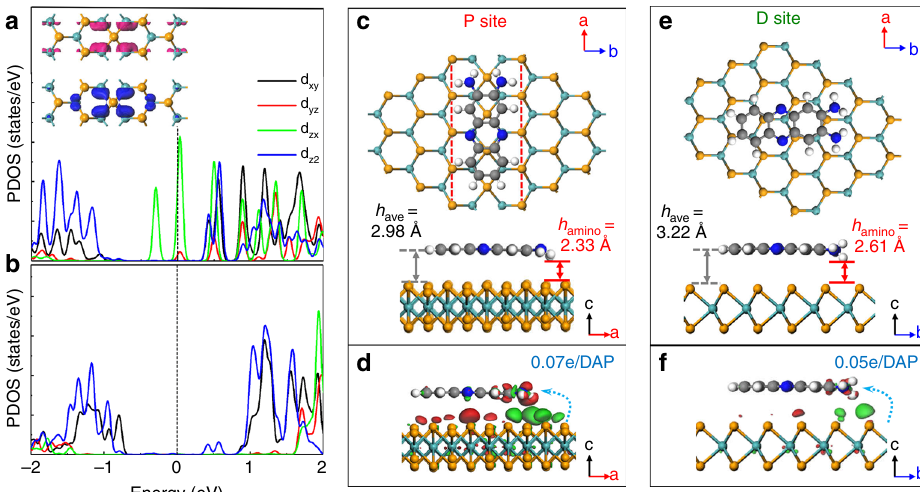
Fig. 5 Optimised con fi gurations of DAP molecules adsorbed on single-layer MoSe 2 surface. a , b The projected density of states of Mo atoms in the MTB and far away from the MTB (only spin-up states are shown here). The inset in a is the partial charge density of electronic states near Fermi level (pink and blue colours denote the states in the range of [0 – 0.3] eV and [ − 0.3-0] eV respectively) with an isosurface value of 2.0× 1.0 − 4 e/Å 3 . c , e Top view and side view of DAP adsorbed on MTBs with a parallel orientation to the MTB (P site), and defect-free MoSe 2 basal plane (D site). h ave and h amino are the equilibrium distance from the centre of DAP molecule or amino group to the top-layer Se of MoSe 2 surface. d , f Charge density difference of P site and D site calculated (cid:2) ρ (cid:2) ρ . The red and green distributions denote the electron accumulation and depletion regions, respectively. The isosurface by ρ ¼ ρ MoSe 2 þ DAP MoSe 2 DAP value of the visualised charge density was set to be 4.0× 1.0 − 4 e/Å 3 . The blue dash-line shows the charge transfer from MoSe 2 to DAP